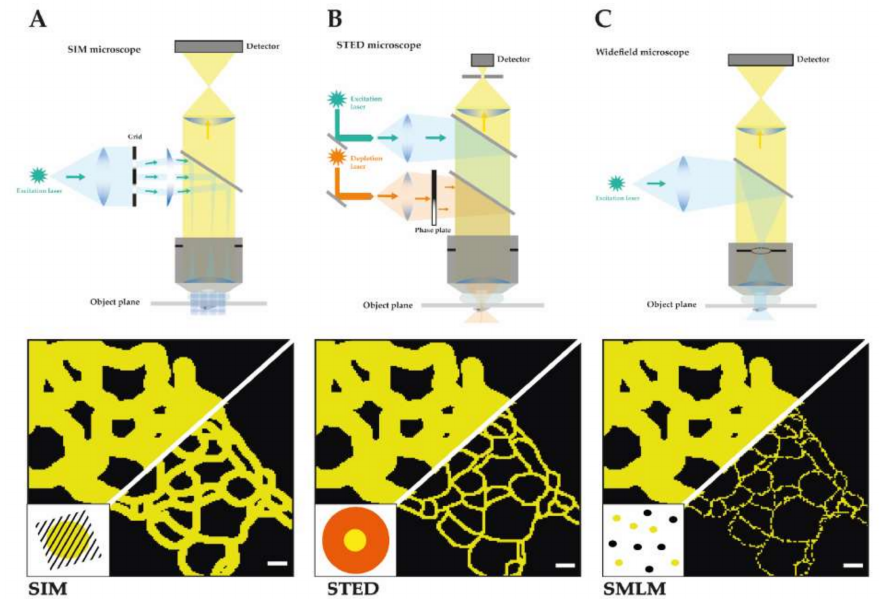
Figure 1. Schematic depiction of the main three SRM techniques. It is shown for each technique a detailed construction of the microscope and the light path as well as a schematic comparison of a reconstituted TJ meshwork resolved by structured illumination microscopy (SIM) (resolution limit: 100 nm) ( A ), time-gated stimulated emission depletion (gSTED) (resolution limit: 40 nm) ( B ), and single molecule localization microscopy (SMLM) (resolution limit: 20 nm) ( C ) in reference to confocal imaged TJ meshwork (resolution limit: 250 nm). Scale bars: 200